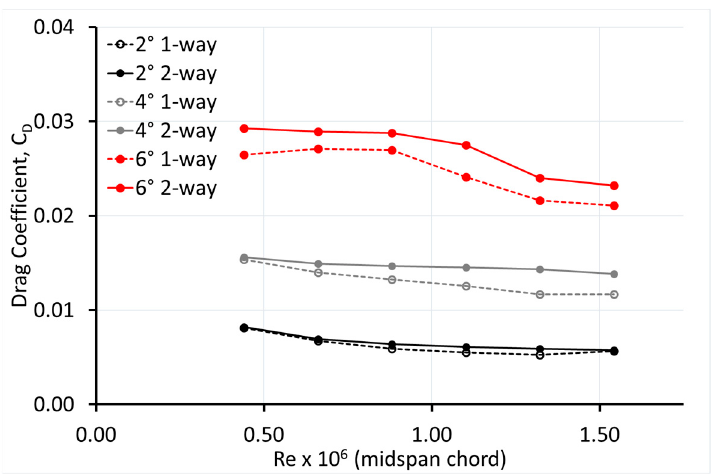
Figure 17. Drag coefficient vs. Reynold’s number.